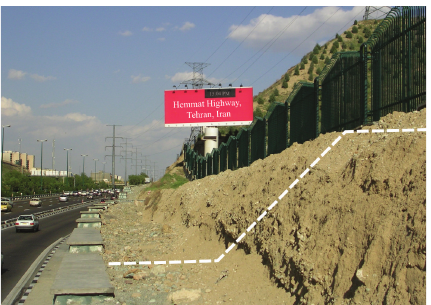
Figure4:Geometryofnaturalslopebehindaretainingwall,Tehran, Iran.